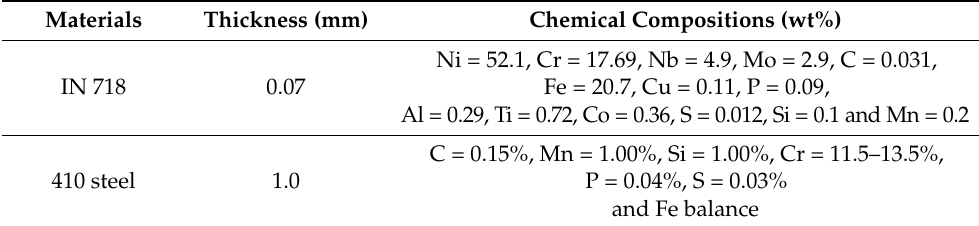
Table 2. Process parameters and their limits.